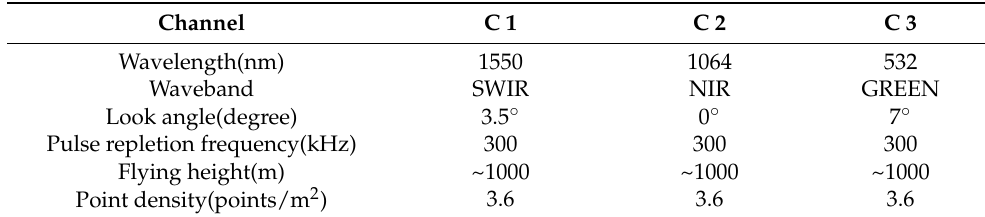
Table 1. Specifications of the Titan